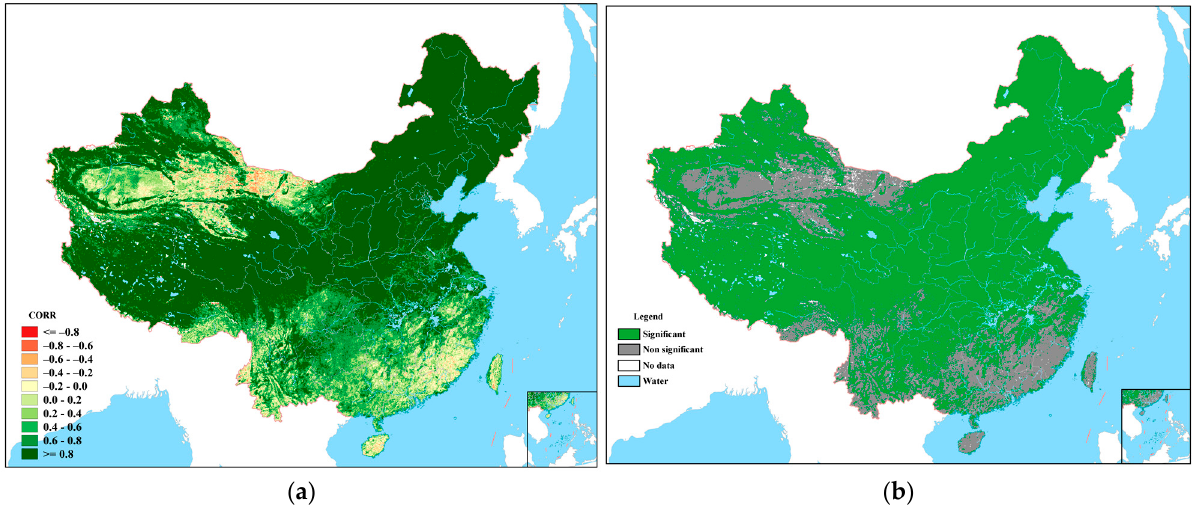
Figure 7. Spatial distribution of the correlation coefficient between FNDVI and MNDVI ( a ) and the statistical significance test for the spatial distribution ( b ).